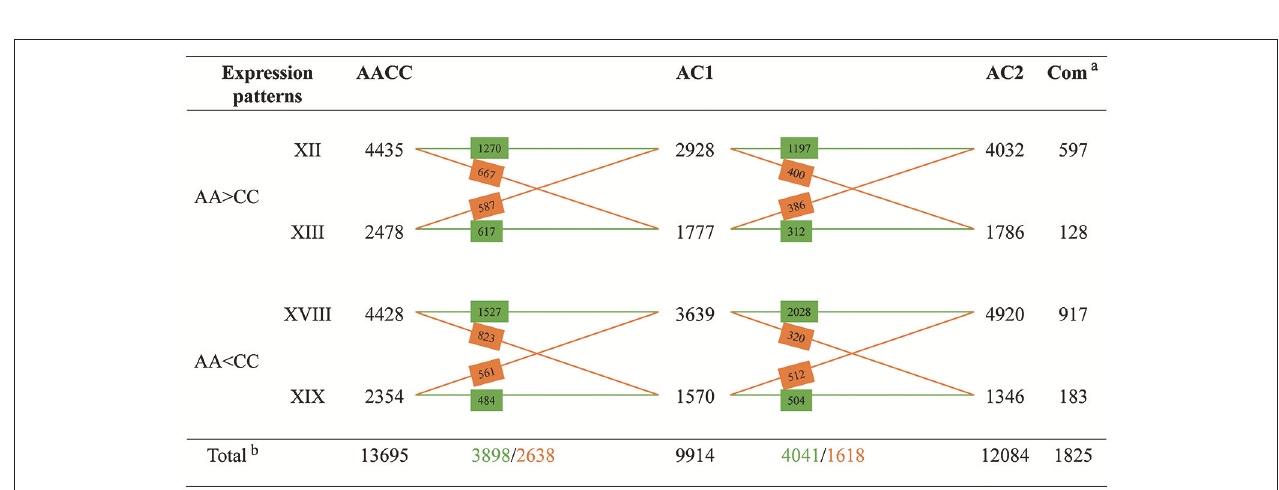
FIGURE 5 | Cross comparisons of the four different patterns of expression level dominance between synthetic hybrids. Numbers of genes shared between different expression patterns are indicated on the cross lines. The green color indicates the number of genes which exhibiting the same pattern between two samples; The orange color indicates the number of genes which showing different expression patterns between two